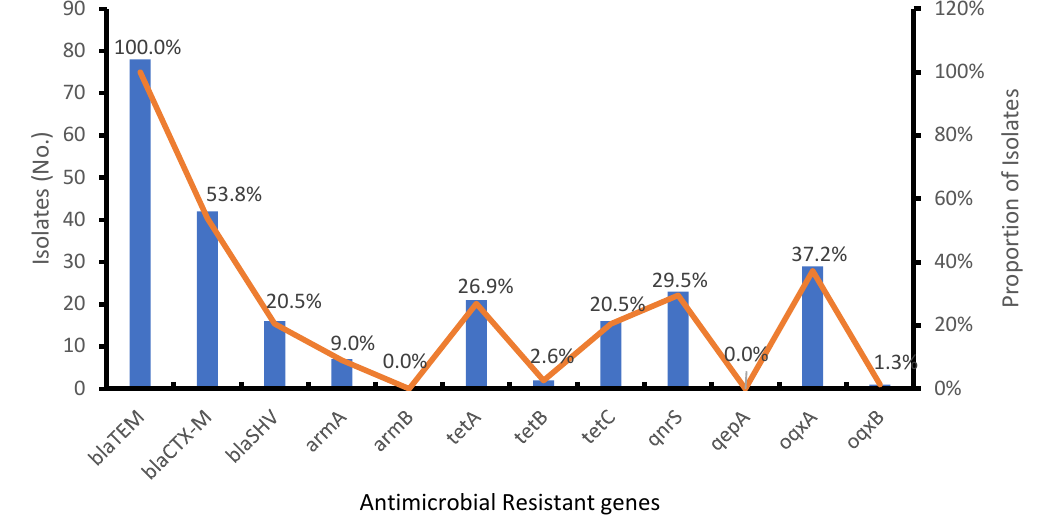
Figure 4. Detection of drug-resistant genes in E. coli . PCR was performed to identify the carriage of β -lactam (blaTEM, blaCTX-M, and blaSHV), aminoglycoside (armA and armB), tetracycline (tetA, tetB, and tetC), and quinolone (qnrS, qepA, oqxA, and oqxB) related genes in 78 E. coli